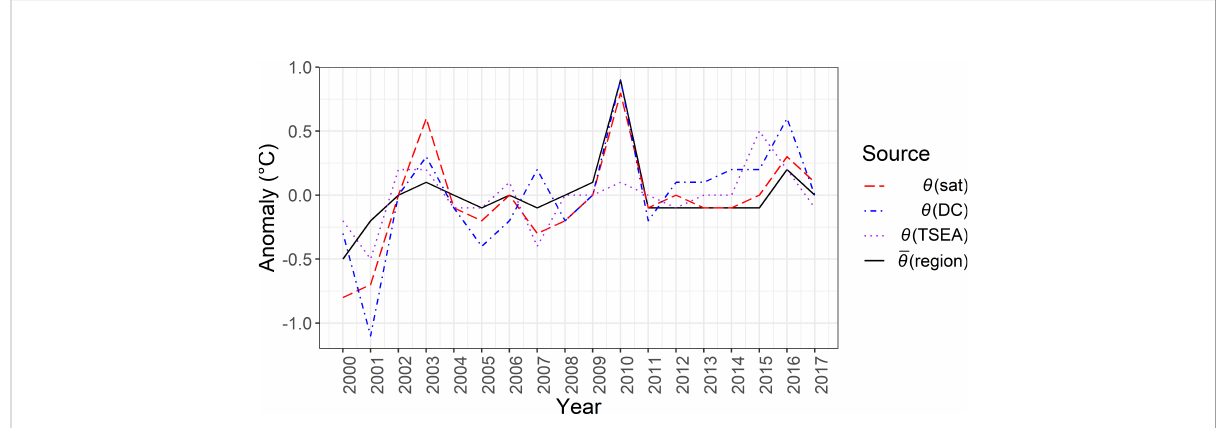
FIGURE 7 Interannual variation in anomalies from mean q (DC), q (sat) and q (TSEA). Red denotes years that are warmer than average (for the data source) and blue cooler than